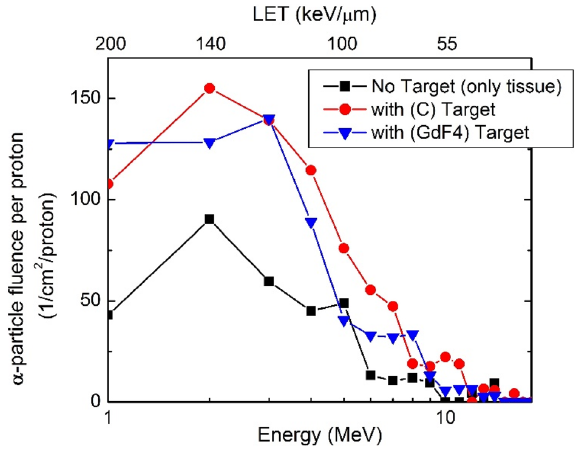
Figure 2. The energy spectrum (and the LET spectrum) of the alpha particles when the cell was irradiated by protons in the presence of one nano-target of C and GdF4 (colored lines) and also without nano-targets (black line). The fluences corresponding to the highest LET particles (> 100 keV/µm) have been increased more significantly than the low LET particles when compared to without nano-target spectrum